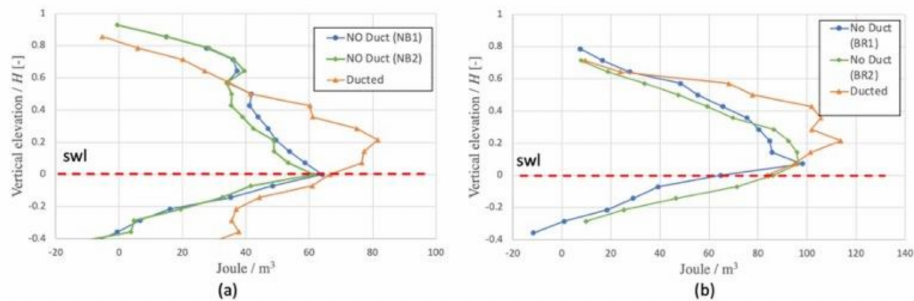
Figure 15. The energy per m 3 of water comparison at ( a ) the near breaking wave zone of the no duct case at ( x / L ) = − 0.175, (blue circle), no duct case at ( x / L ) = − 0.25 (green diamond), and the ducted case (orange triangle); and ( b ) the broken wave zone of the no duct case at ( x / L ) = 0.075 (blue circle), no duct case at ( x / L ) = 0.125 (green diamond) and ducted case (orange triangle). Here L denotes the shallow water